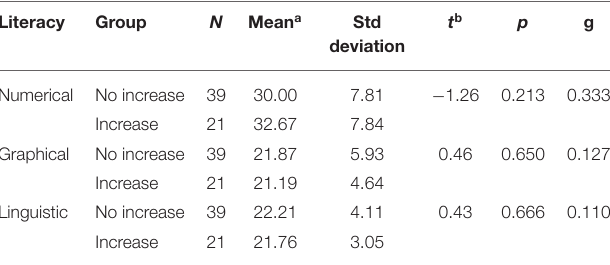
TABLE 1 | Differences in numeracy, graph literacy, and linguistic literacy between groups with no increase in literacy and those with an increase because of debt